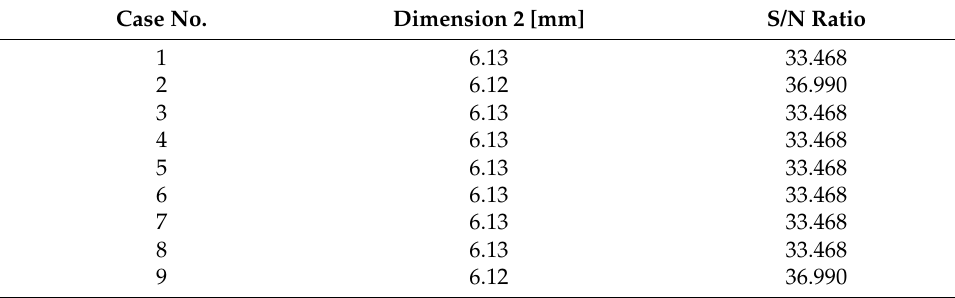
Table 14. S/N ratio of measurement 2 for pivot